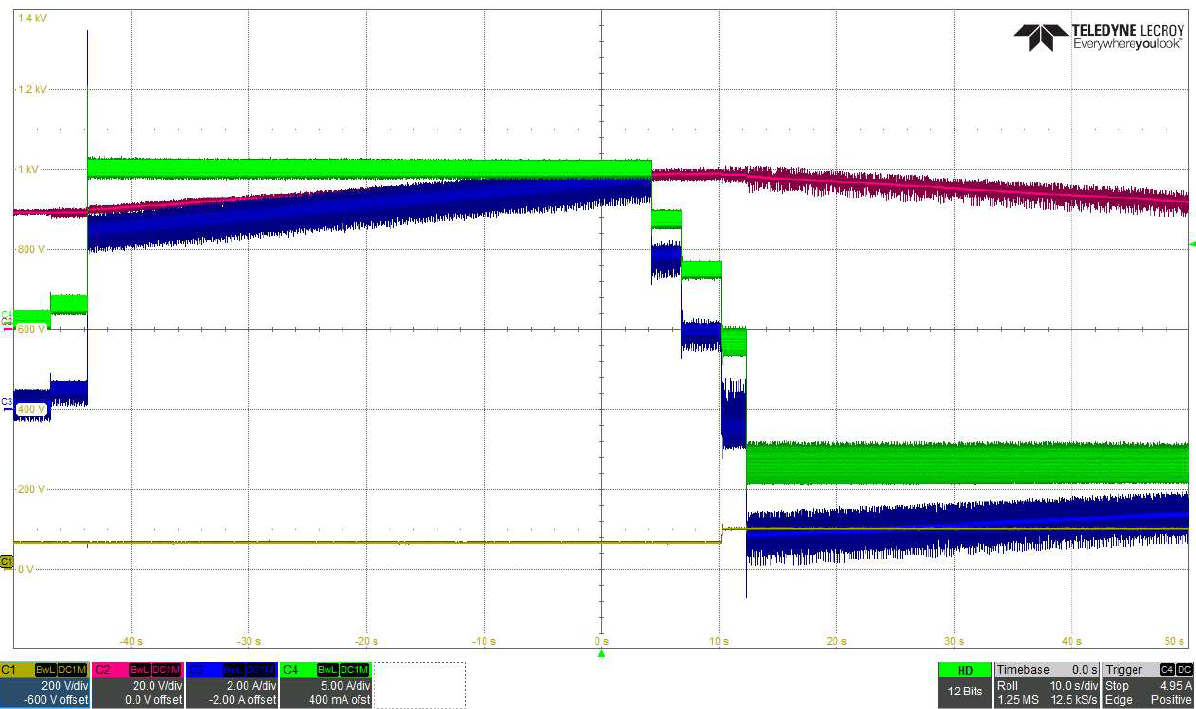
Figure 31. Experimental BHSC waveforms. Supercapacitor charging/discharging. Operating condi- tions: V H = 100 V, V L = 30…45 V…30 V, I L1 is controlled in steps to charge and discharge the super- capacitor. C2: V L ; C3: i L2 ; C4: i L1 . ditions: V H = 100 V, V L = 30 . . . 45 V . . . 30 V, I L1 is controlled in steps to charge and discharge the supercapacitor. C2: V L ; C3: i L2 ; C4: i L1